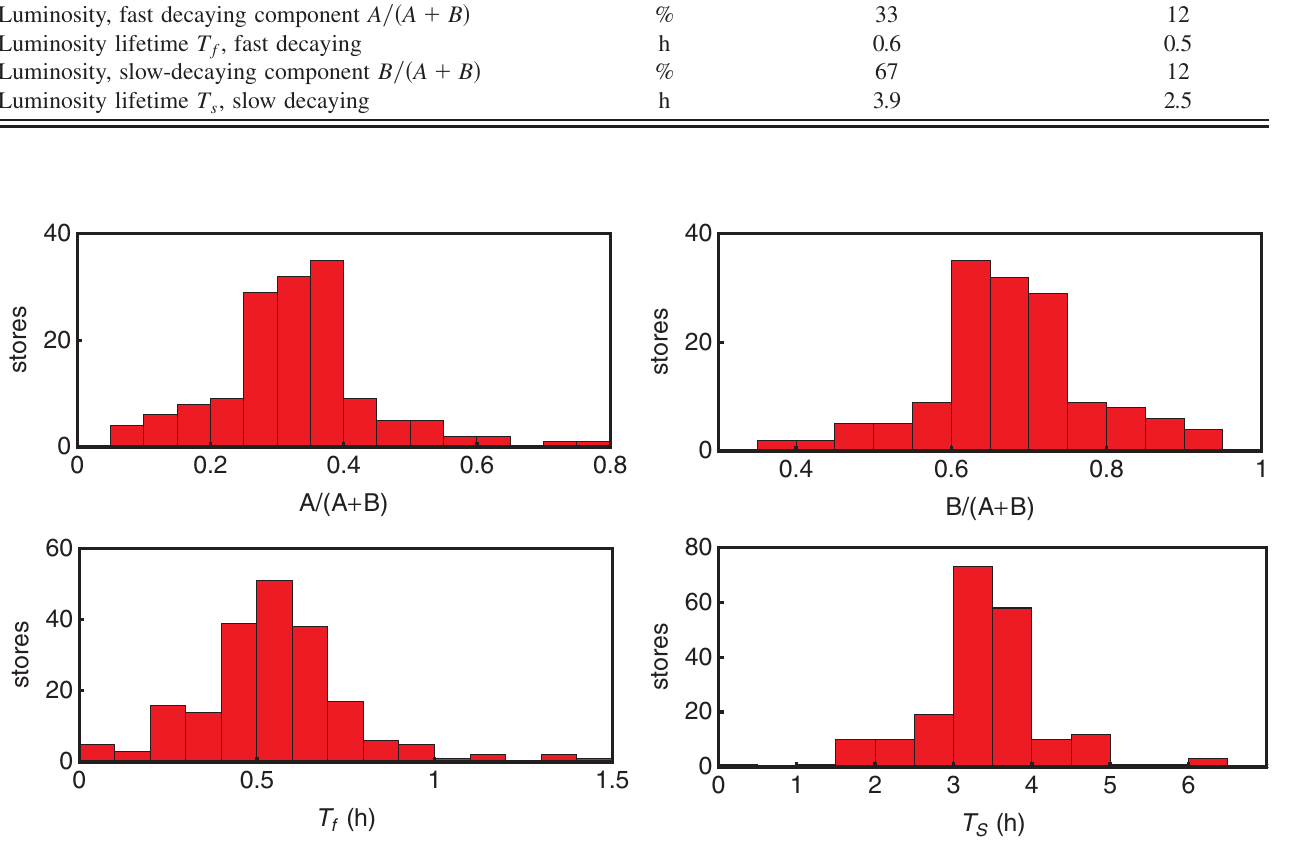
FIG. 2. (Color) Distributions of fitted luminosity lifetime parameters defined by Eq. (2), where T f is chosen to be the faster decay time and T s the slower.